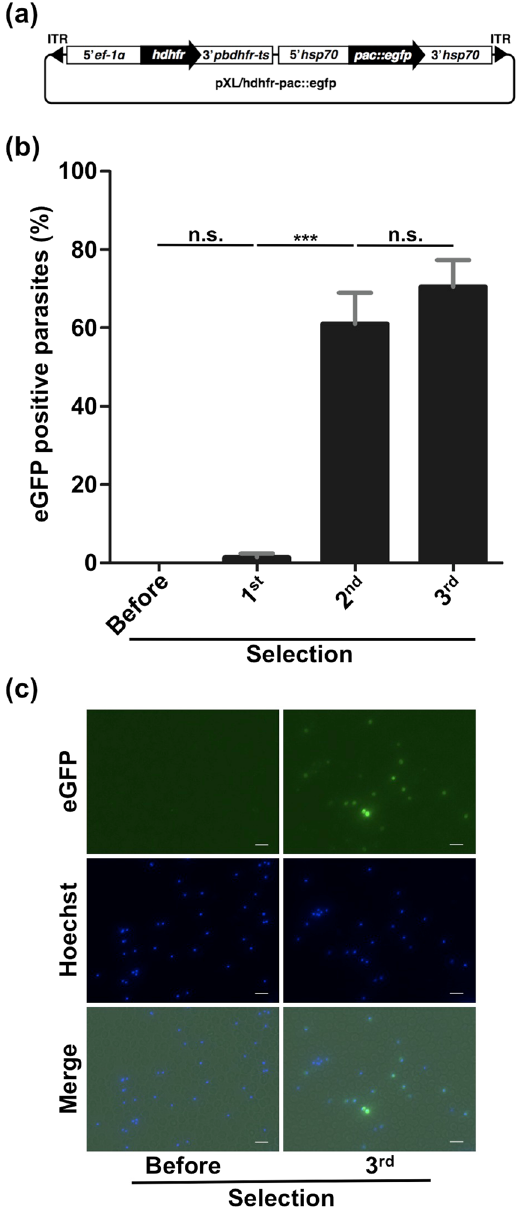
Figure 5. Generation of mutants using the pac::egfp fusion marker. ( a ) Schematic diagram of piggyBac transposon vector containing the pac::egfp fusion marker (pXL/hdhfr-pac::egfp). ITR: inverted terminal repeat. ( b ) eGFP-positive parasite ratios after each puromycin selection. Ratios were analyzed using fluorescence microscopy. Each bar represents the mean ± SD of four independent experiments. *** p < 0.001, n.s.: not significant (paired t -tests). ( c ) Fluorescence images of parasites before selection and after the third selection containing the pac::egfp fusion marker. Parasites were stained with Hoechst 33342. The scale bar represents 10 µ